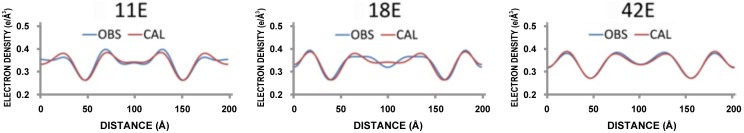
Position-dependent profiles for lamellar myelin consistent with differing ratios of myelin proteins.Electron density distribution on an absolute scale for data from diffraction patterns #11E, 18E, and 42E, where E refers to scattering along the equator. The observed and calculated structure factors on a relative scale are indicated in Table 1. (The absolute scaling method is described in S.I., Section 1.) The differences in the levels of electron density in the lipid polar head group layers at the cytoplasmic and extracellular sides of the membrane bilayer are interpreted in terms of a heterogeneous distribution of MBP and P0 glycoprotein in different regions of the myelin sheath (see Text for details).